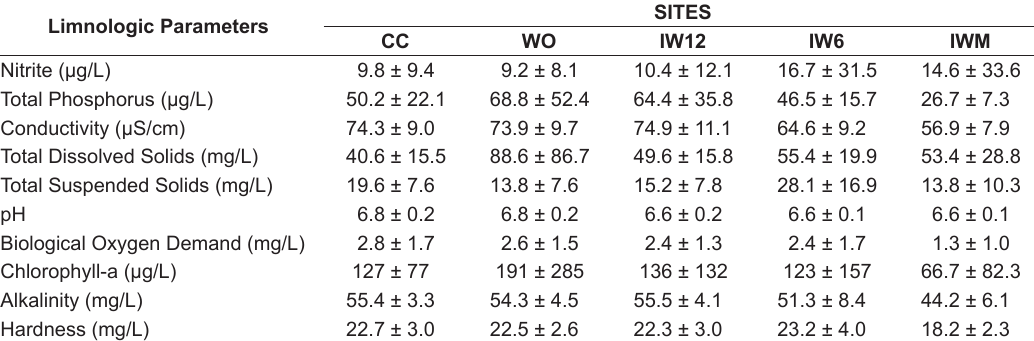
Table 1. Mean and standard deviation of water variables collected in five sites during the studied